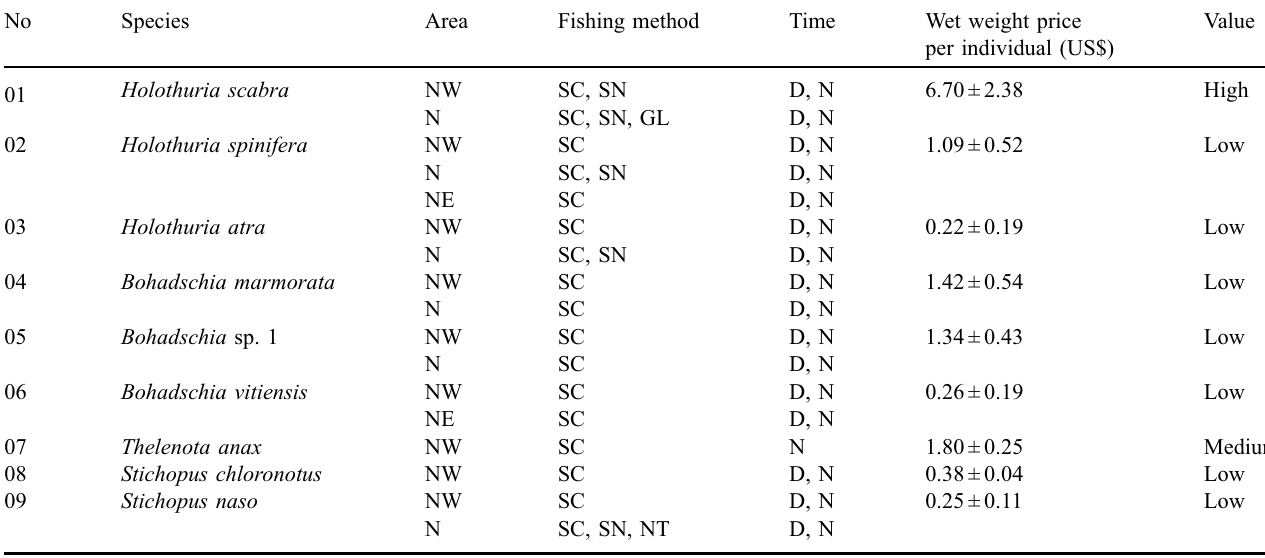
Table 2. Scienti fi c name, fi shing time, fi shing method, commercial value and the average price of the fresh individual (US$) of sea cucumber species in the commercial catches of the north-west (NW), north (N) and north-east (NE) coasts of Sri from November 2015 to January